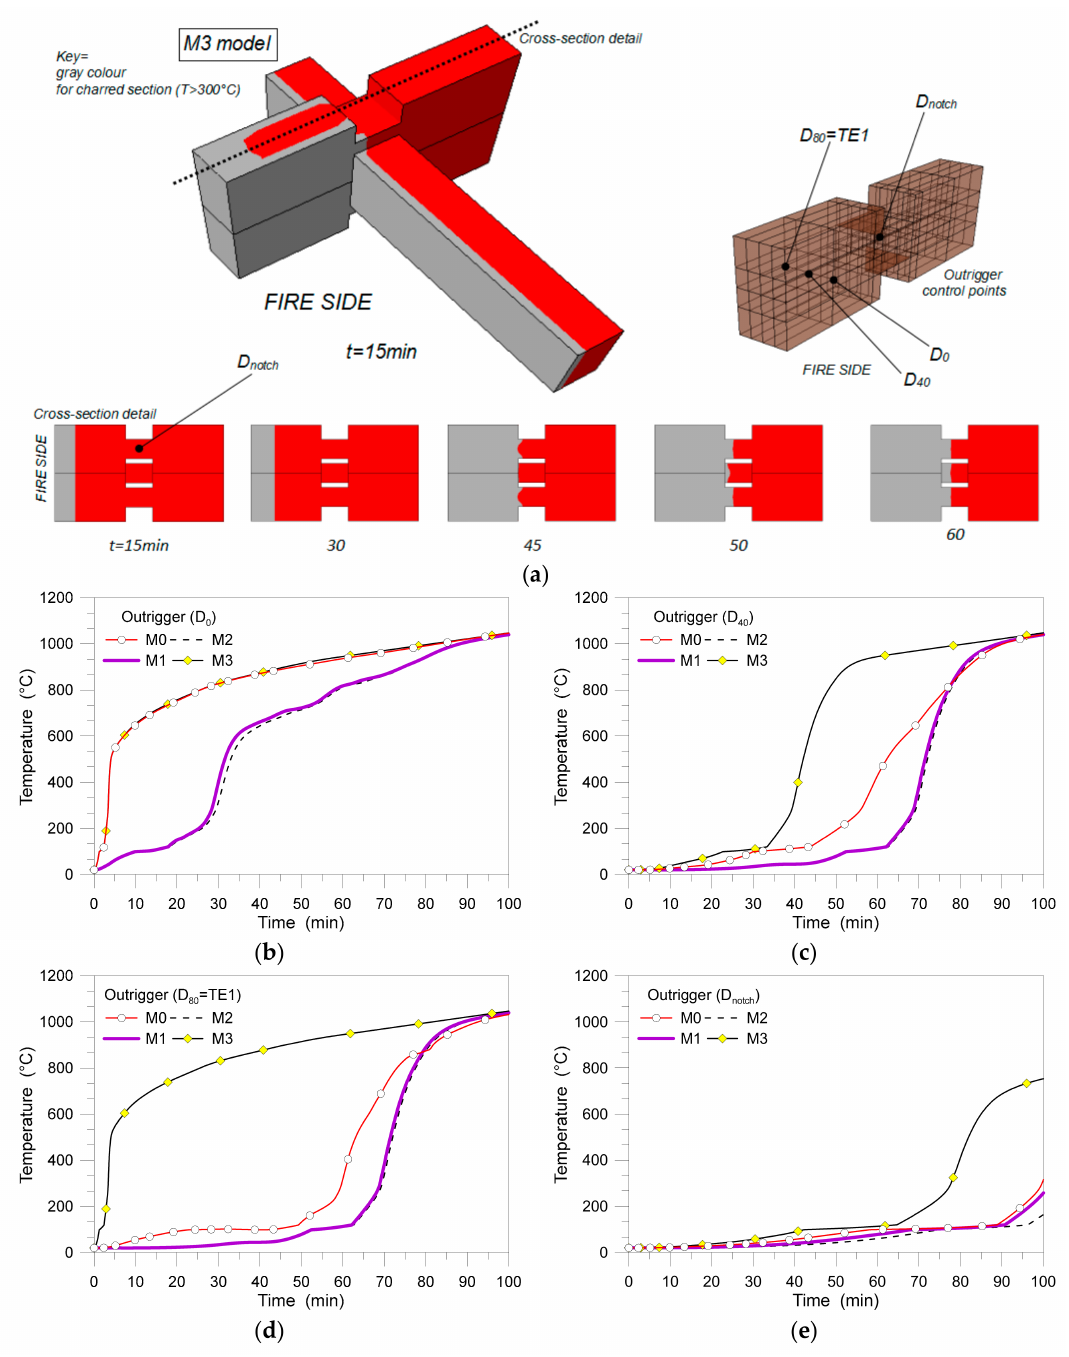
Figure 13. FE heat transfer results (ABAQUS). ( a ) Residual section evolution in selected logs, after t = 15-to-60 min of EN/ISO standard time-temperature loading, as obtained for the M3 model; ( b – e ) time-temperature comparative plots for selected control points (M0-to-M3 models). The M0-to-M3 systems were numerically investigated by means of FE models still derived from Section 3, but without the set of surface-to-surface contact interactions at the interface between timber logs, being replaced by fully ‘tie’ rigid contacts enabling possible relative rotations and displacements at the logs interfaces. Selected comparisons are proposed in Figure 14b, giving evidence of the fire performance for the ‘limit’ conditions of fully protected (M2) and unprotected (M3) models. There, the label ‘m’ is used to denote the monolithic systems, compared to